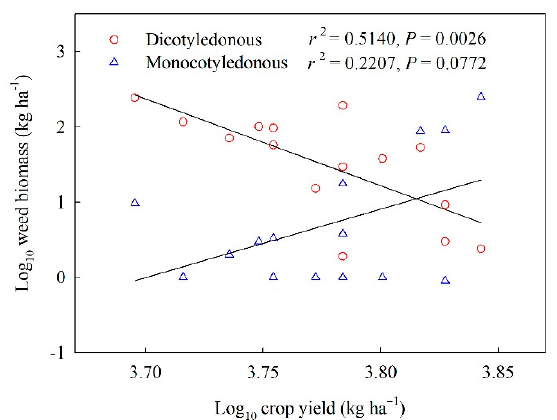
Figure 6. Correlation between crop yield and the aboveground biomass of dicotyledonous weeds and monocotyledonous